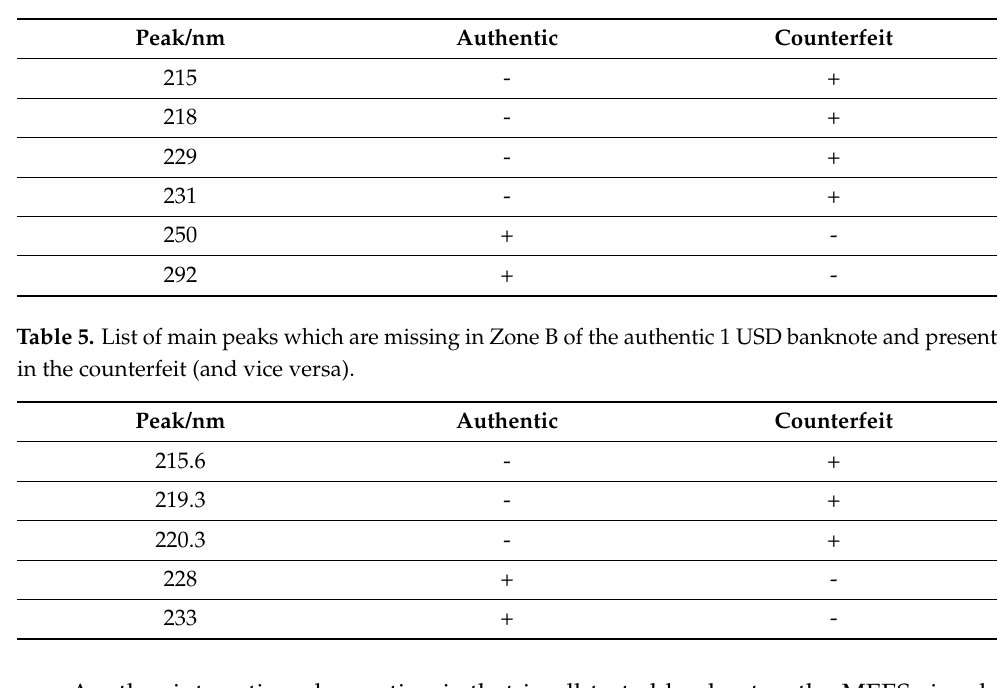
in the counterfeit (and vice versa).